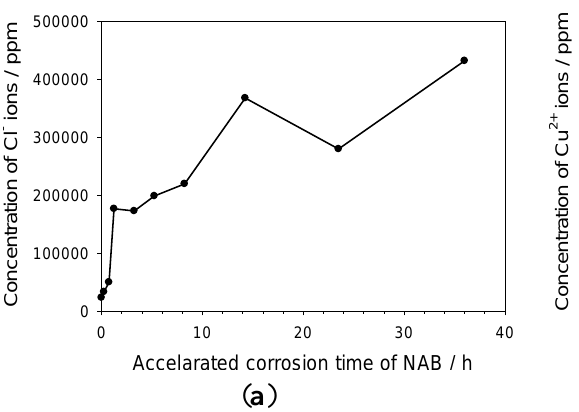
Figure 10. Concentration profiles of ( a ) chloride and ( b ) cupric ions as a function of accelerated corrosion time for NAB in 3.5% NaCl